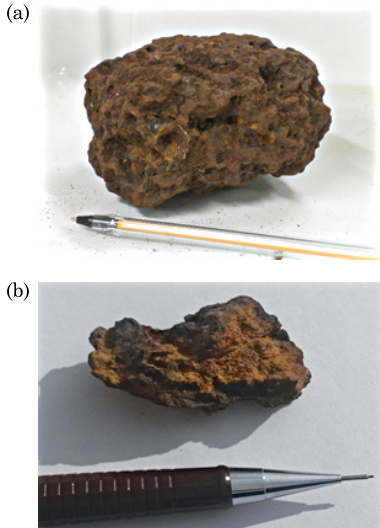
Figure 2. (a) Natural fragment of ironstone used for bulk and particle density determination (note root remains on the surface); (b) ironstone fragment showing a black color due to predominance of macrocystalline Fe oxides, and yellowish masses suggesting oxide hydration and disintegration.